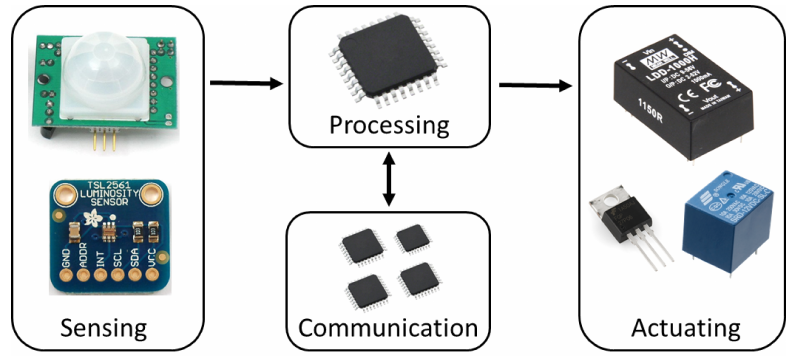
Figure 8. Simplification of smart lighting essentials: sensing, processing, actuating and